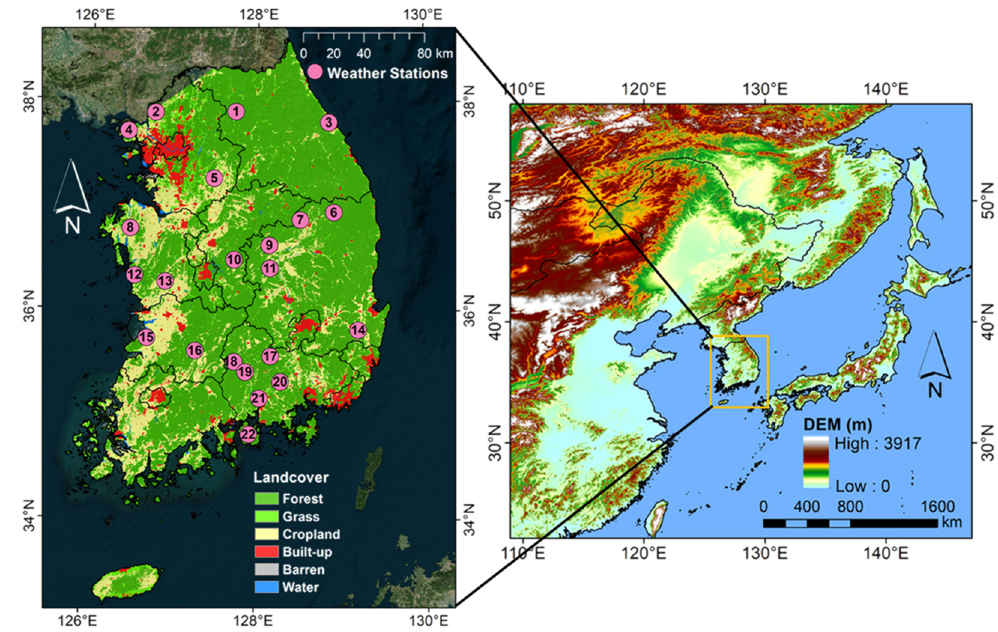
Figure 1. Study area and spatial distribution of the weather stations used in this study. Station num- bers are labeled in order of decreasing latitude. Elevation is derived from Shuttle Radar Topography Mission (SRTM) digital elevation model (DEM) with 90 m spatial resolution. Land cover is extracted from the MODIS land cover with 500 m spatial resolution for